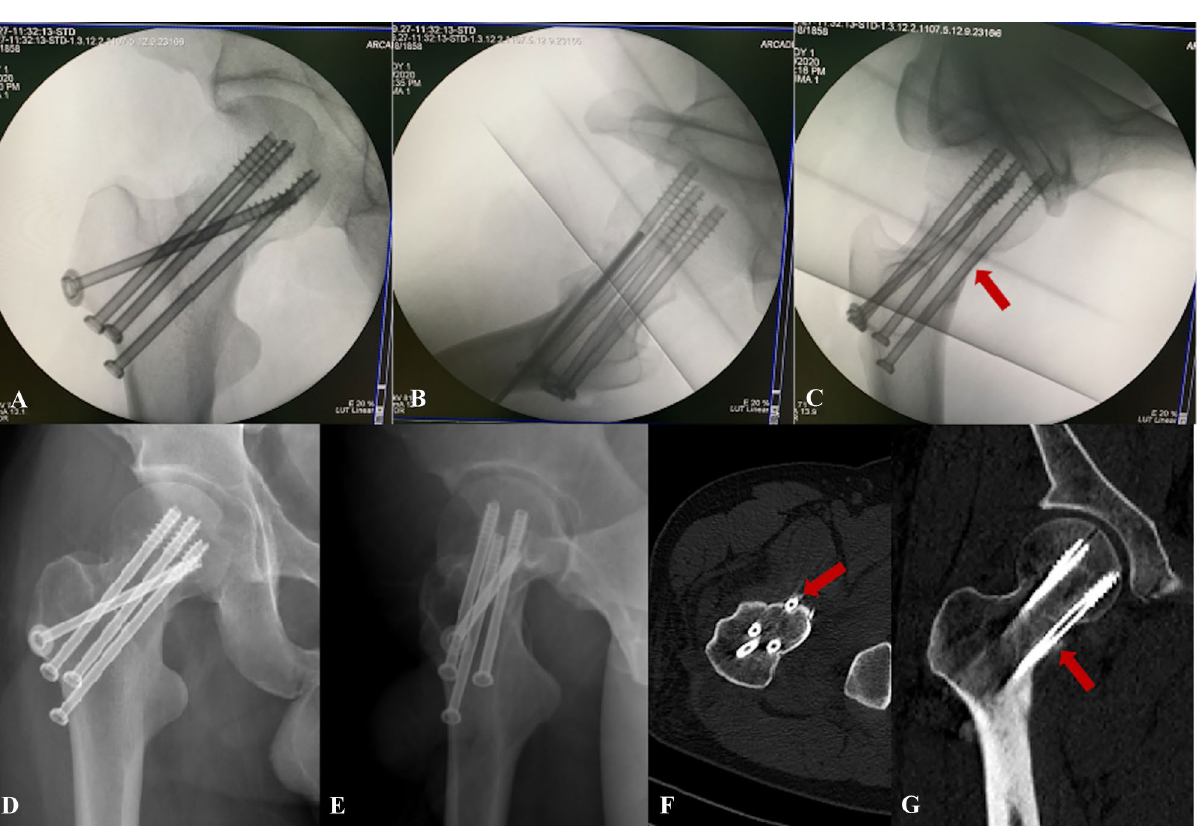
Figure 5. ( A , B ) Intra-operative the AP and lateral views showed all screws were contained. ( C ) Intra-operative the tangential view showed the inferior screw IOI. ( D , E ) Postoperative plain radiographs showed all screws were contained. ( F , G ) Postoperative CT showed the inferior screw IOI. The red arrow represents the inferior screw